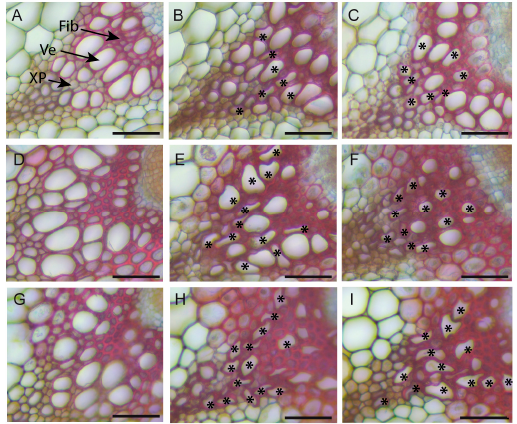
Figure 9. Observation of irregular xylem vessels under high salinity in the stem of Arabidopsis . Details of the xylem cells in the vascular bundles of Ctrl, PStr, and SStr plants at 17 DAB, observed in the stem section after staining with Safranin O and Alcian Blue. ( A , D , G ) Ctrl Plants, ( B , E , H ) PStr plants, ( C , F , I ), and SStr plants for Col0 ( A – C ), Ct1 ( D – F ), and Tsu0 ( G – I ). Stars (*) indicate irx vessels. Ve—vessel. Fib—xylem fiber. XP—xylem parenchyma cell. Bars = 50 µ